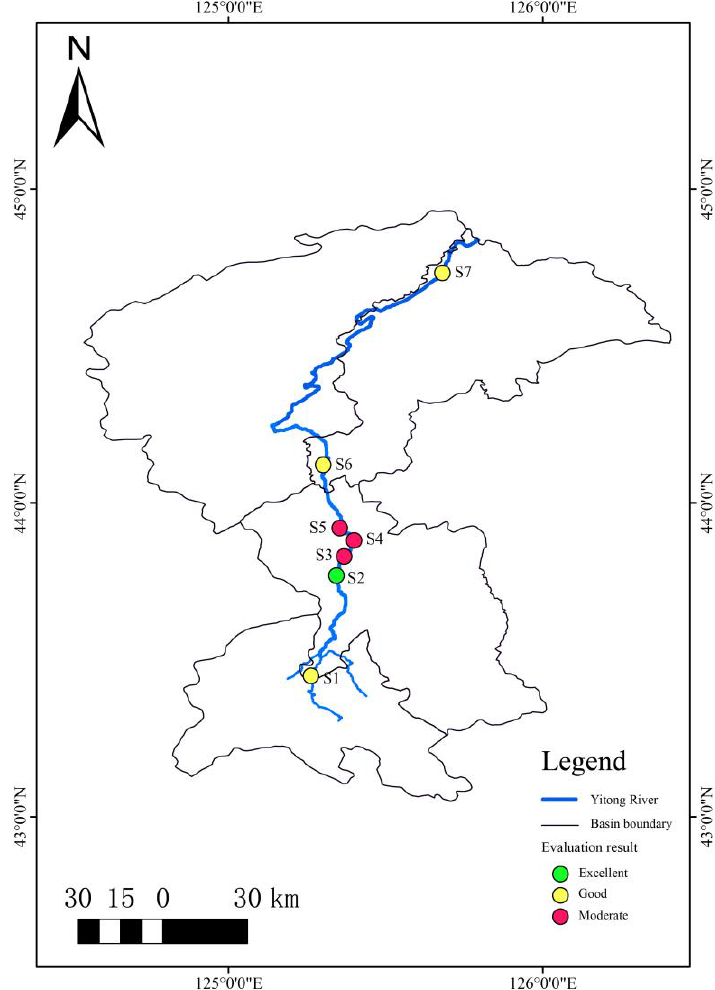
Figure 4. Spatial distribution of the P – IBI based on seasonally averaged data.